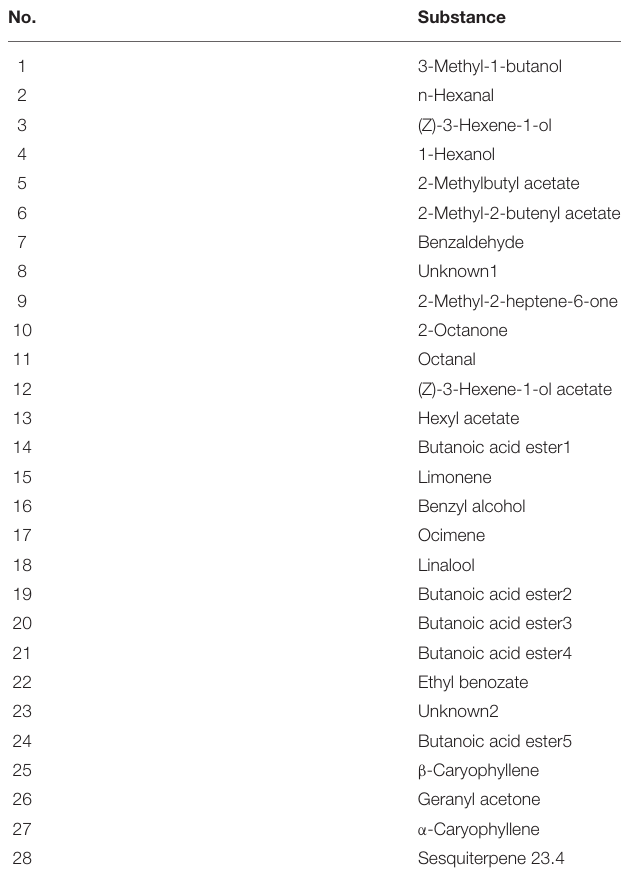
TABLE 1 | Volatile compounds of tobacco plants included in statistical analysis.